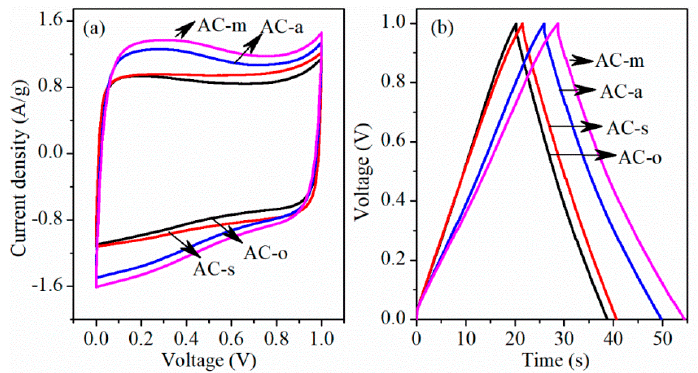
Figure 9. CV curves at a scan rate of 50 mV/s in 6 M KOH aqueous solution ( a ) and galvanostatic charge-discharge curves at the current density of 1 A/g ( b ) in two-electrode system. Materials 2018 , 11 , x FOR PEER REVIEW